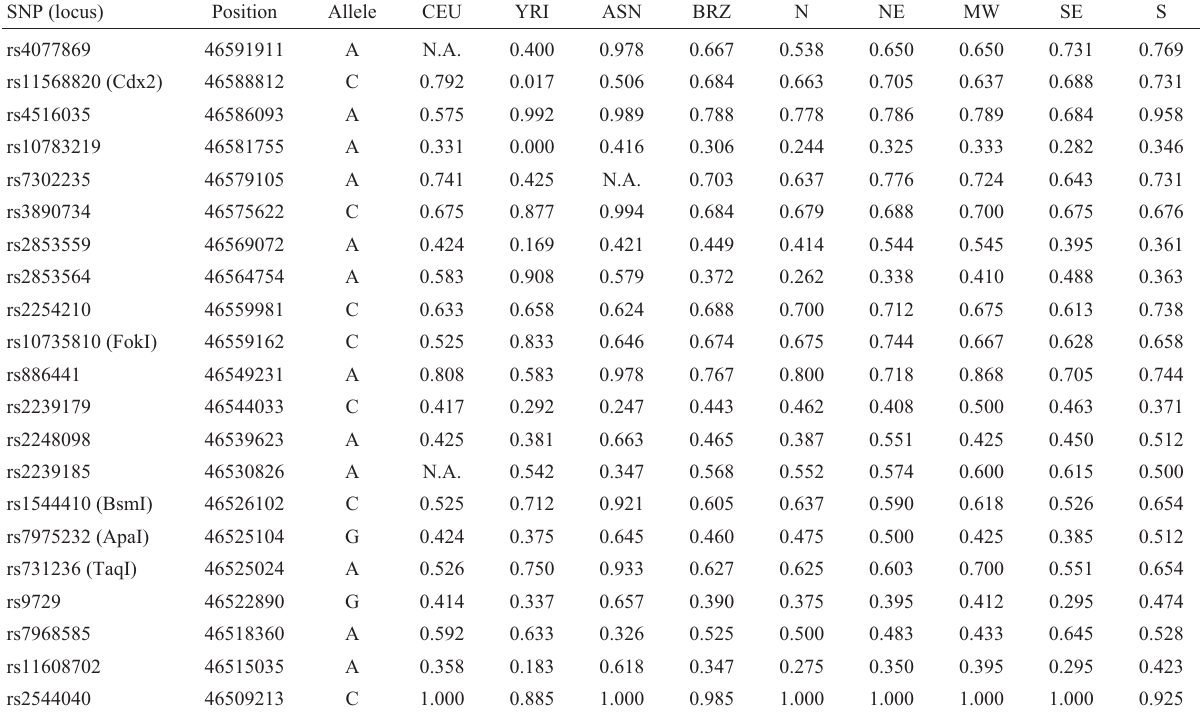
Table 1 - SNPs genotyped in the VDR gene and their chromosomal position (chromosome 12 genomic contig, NT_029419.11) and allelic frequencies in the samples from the HapMap populations, the total Brazilian population and the five geopolitical regional samples. SNP (locus) Position Allele CEU YRI ASN BRZ N NE MW SE S rs4077869 46591911 A N.A. 0.400